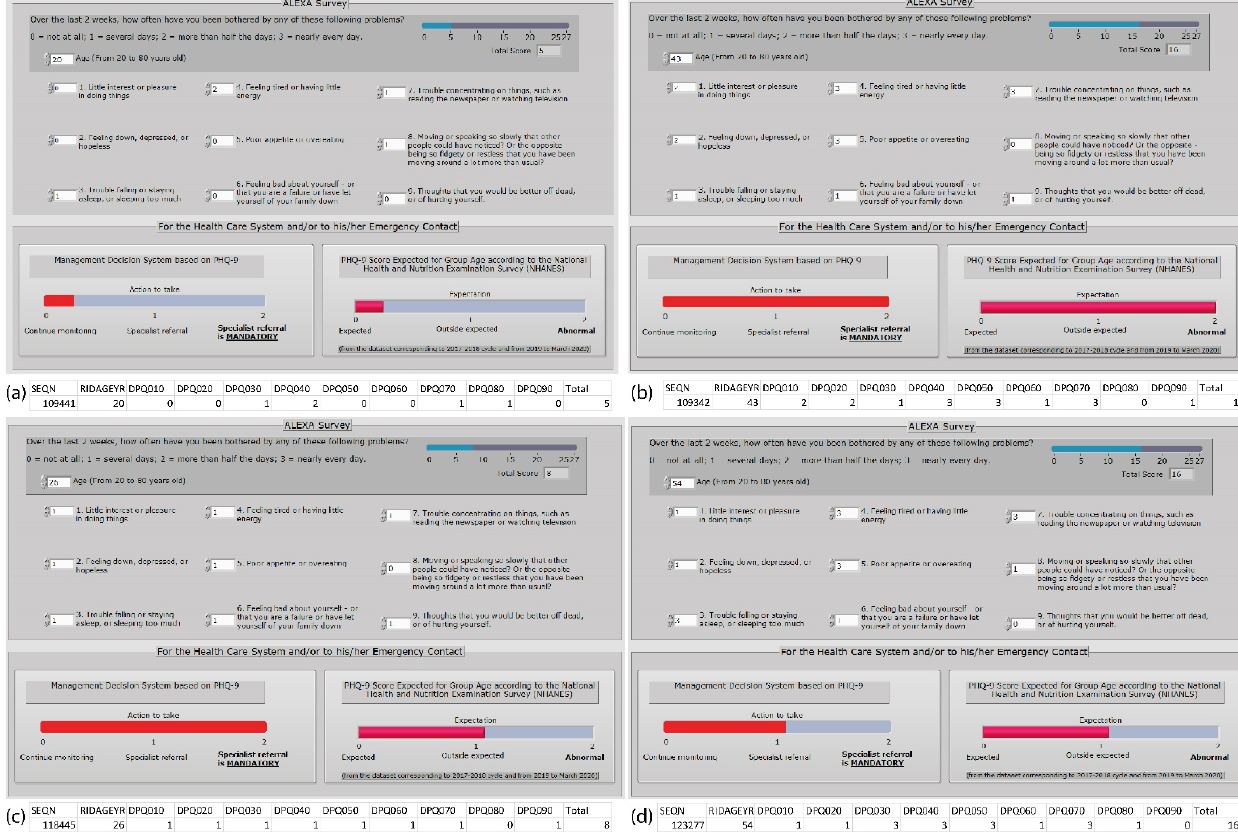
Figure 7. Dashboard results: ( a ) 20 years old individual with a total score of 5; ( b ) 43 years old individual with a total score of 16 and suicidal thoughts; ( c ) 26 years old individual with a total score of 8 and suicidal thoughts; ( d ) 54 years old user with a total score of 16.